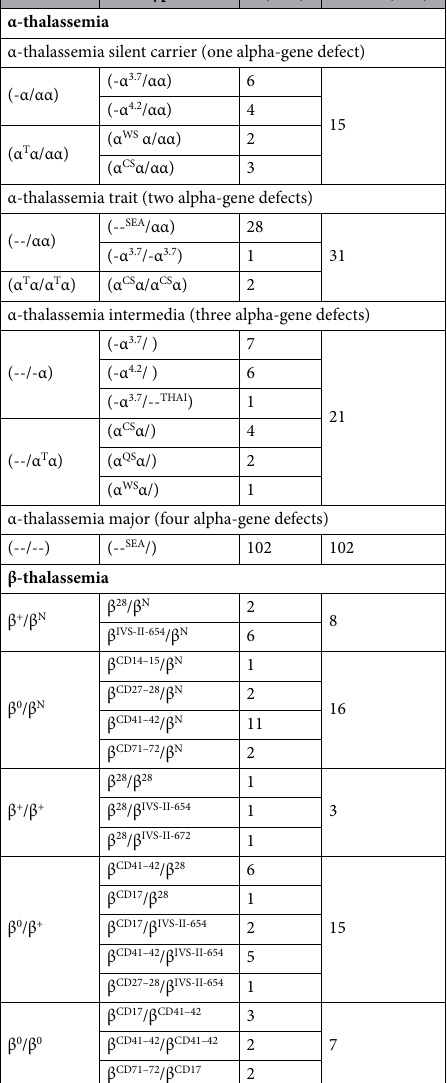
Table 1. The distribution of genotype in α-thalassemia and β-thalassemia.